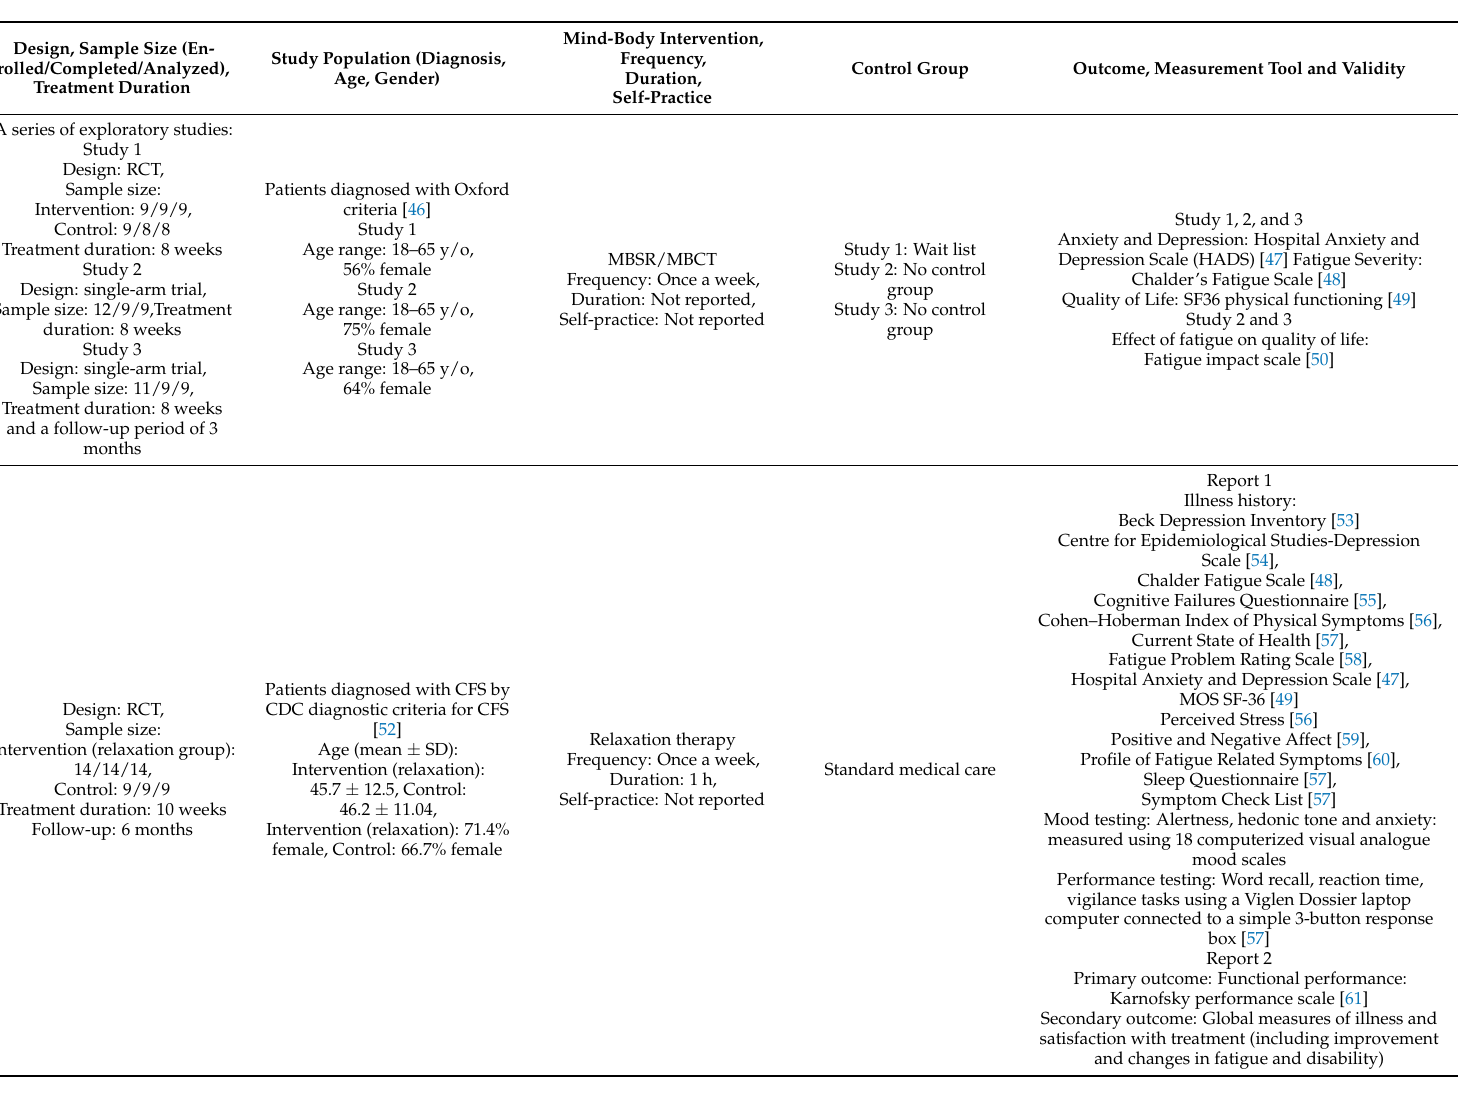
Table 2. General characteristics of the included